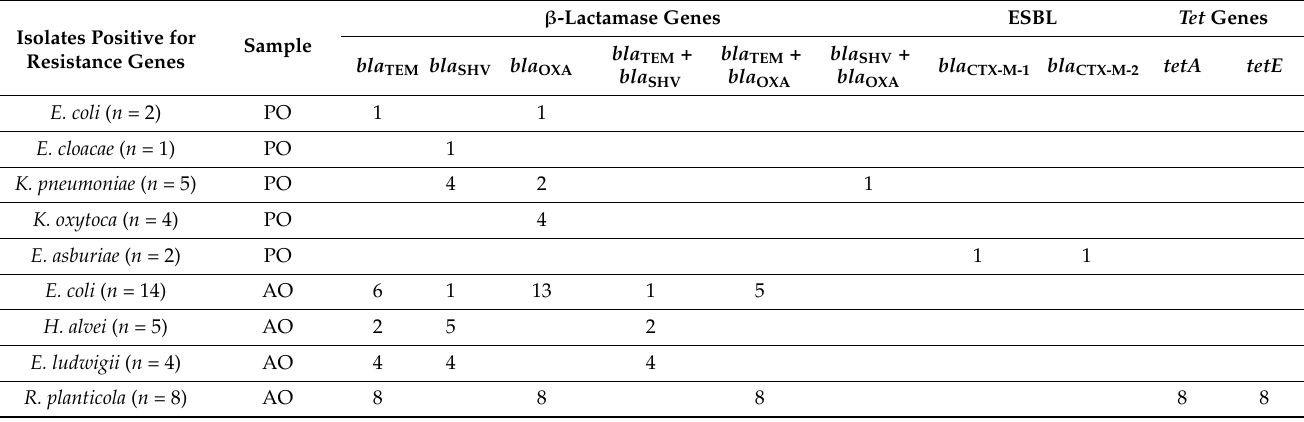
Table 4. Specific resistance genes in isolates of food chain detected by multiplex PCR.